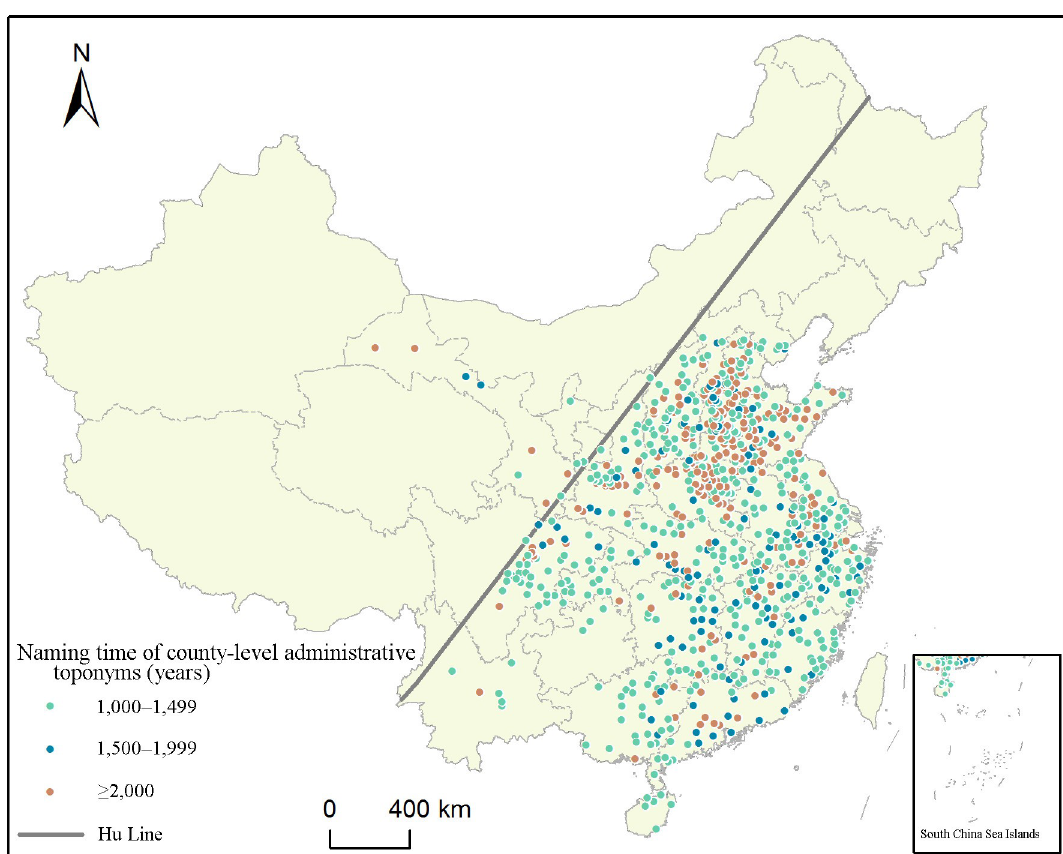
Fig 1. Distribution map of county-level administrative toponyms with the time of being named from 1,000 years ago. The dots represent data on county-level administrative toponyms with naming time from 1,000 years ago. The green dots represent county- level administrative toponyms being named for 1,000–1,499 years, blue dots those being named for 1,500–1,999 years, and red dots those being named for 2,000 years